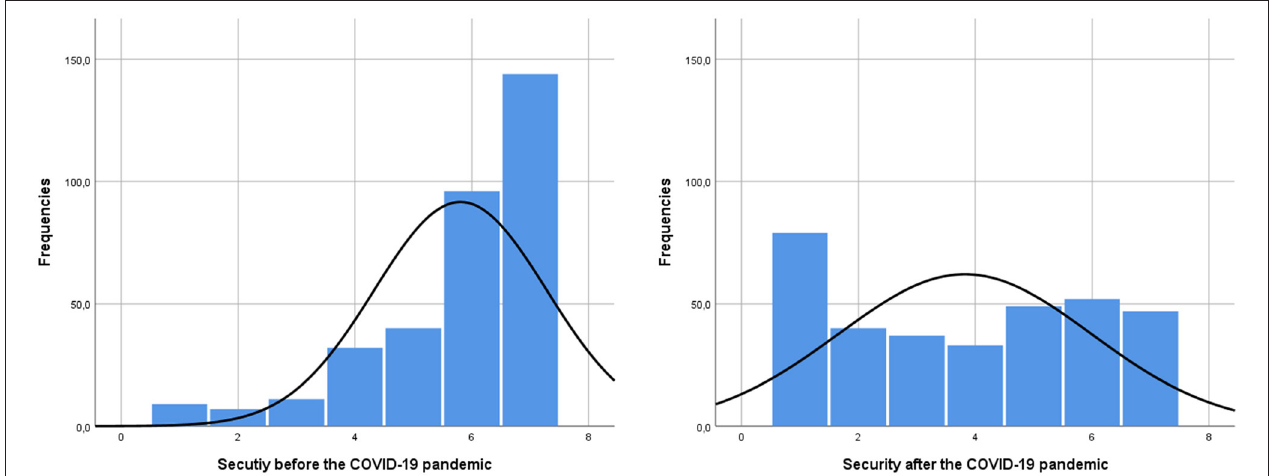
FIGURE 1 | The distribution of subjective sense of workplace security before and after the pandemic outbreak.